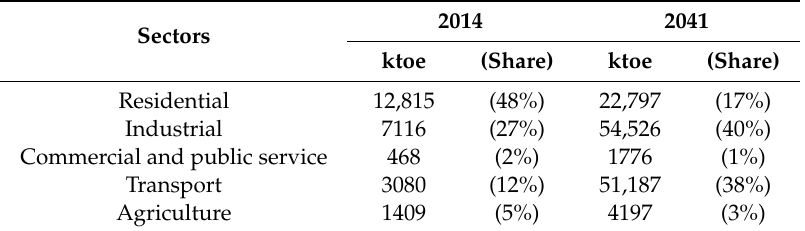
Table 1. Total energy consumption—business as usual (BAU) scenario [19,22].